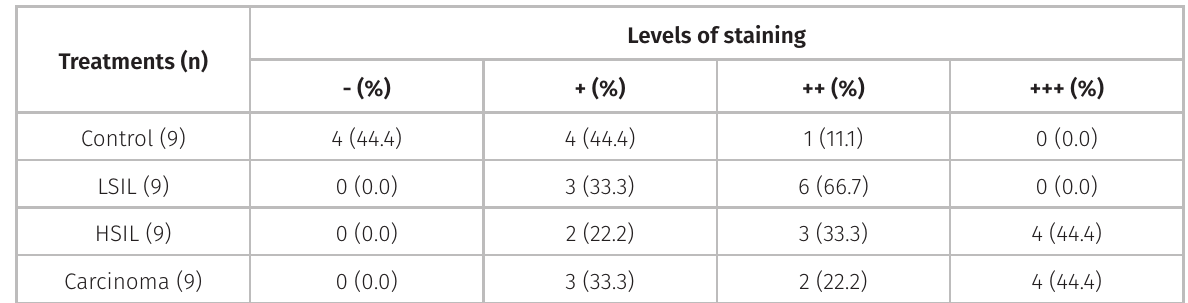
Table I. FASN expression in cervical tissue.